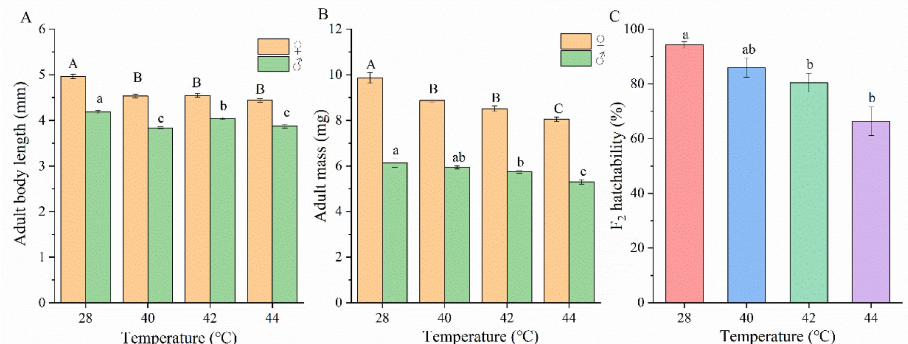
Figure 7. Effects of different temperatures on the adult fitness of the ragweed beetle Ophraella communa . ( A ): adult length, ( B ): adult mass, ( C ): F 2 egg hatchability. Mean ± SE; different lowercase or capital letter are statistically different at p < 0.05 level of the same sex in the same fitness. Experimental temperatures of 40, 42, and 44 °C were imposed on different stages of O. communa in environmental chambers from 12:00–15:00 daily until a generation was completed. A standard temperature of 28 °C was otherwise used for other life stages and the control